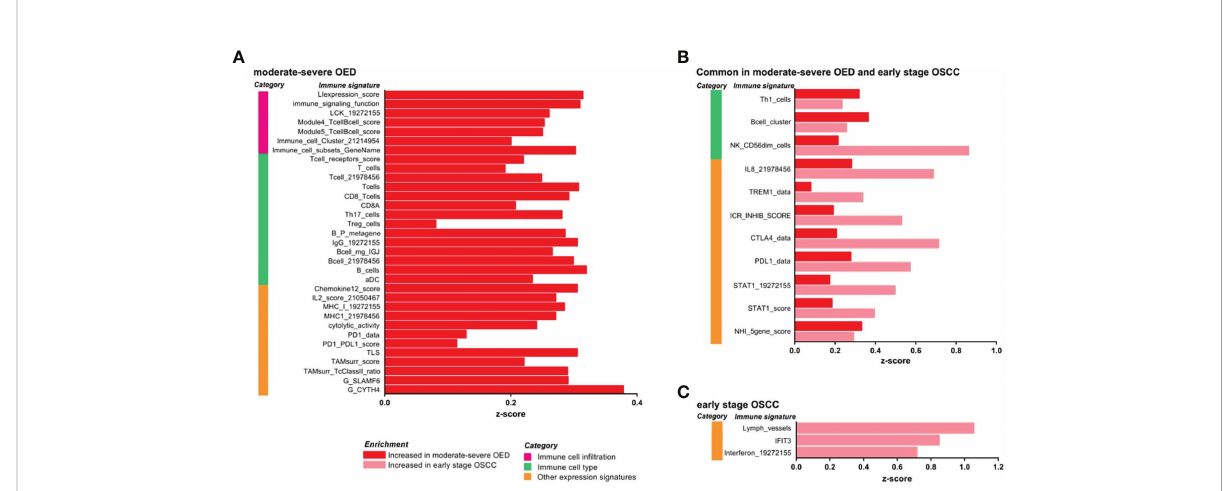
FIGURE 3 IImmune signature enrichment analysis revealed the similarity and differences of immune response underlying the immune in fi ltrates in moderate-severe OED and early stage OSCC. (A) Immune signatures enriched in moderate-severe OED. Immune signatures representing immune cell in fi ltration, T cells and CD8 T cells and cytotoxic response were enriched suggesting an active immunosurveillance is ongoing in moderate-severe OED. At the same time, induction of immune suppressive mechanisms such as Treg and immune checkpoints ( PD-1/PD-L1 ) were detected. (B) Immune signatures commonly enriched in moderate-severe OED and early stage OSCC. Immune signatures for Th1, B cells and cytotoxic NK cells are commonly enriched in both moderate-severe OED and early stage OSCC. Notably, those involve in pro-in fl ammatory responses (IL8, TREM1 and STAT1) and immune checkpoints (ICR_INHIB_score, PD-L1 and CTLA4 ) were further enriched in early stage OSCC compared to moderate-severe OED. (C) Immune signatures enriched in early stage OSCC. Immune signatures representing interferon and lymphatic vessels were enriched in early stage